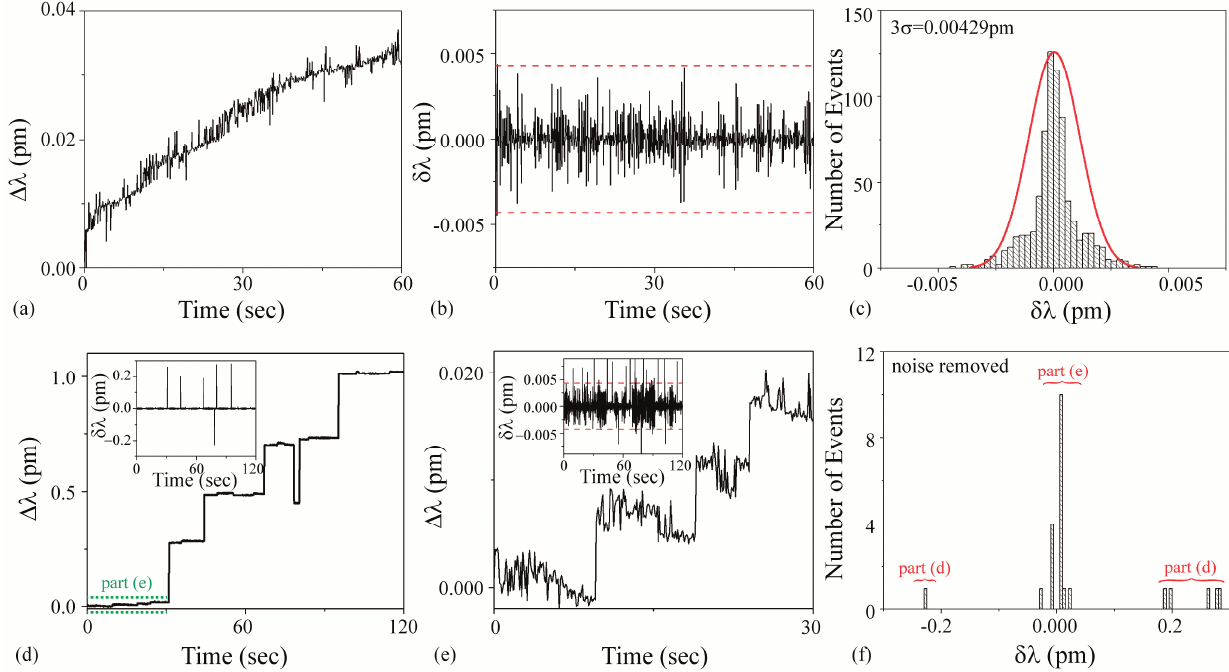
Figure 6. Cow solution: ( a – c ) background and ( d – f ) detection experiments. ( a ) Background wavelength shift ( Δλ ) results; ( b ) background instantaneous wavelength shift ( δλ ) results calculated from part (a) data. The dashed line is the 3 σ noise level determined in part (c); ( c ) histogram of background δλ results calculated from part (b) data. Based on these results, the 3 σ noise is 0.00429 pm; ( d ) wavelength shift ( Δλ ) upon injection of Cow solution. Inset: Instantaneous wavelength shift ( δλ ) results calculated from this data. ( e ) wavelength shift ( Δλ ) during first 30 s upon injection of Cow solution (region